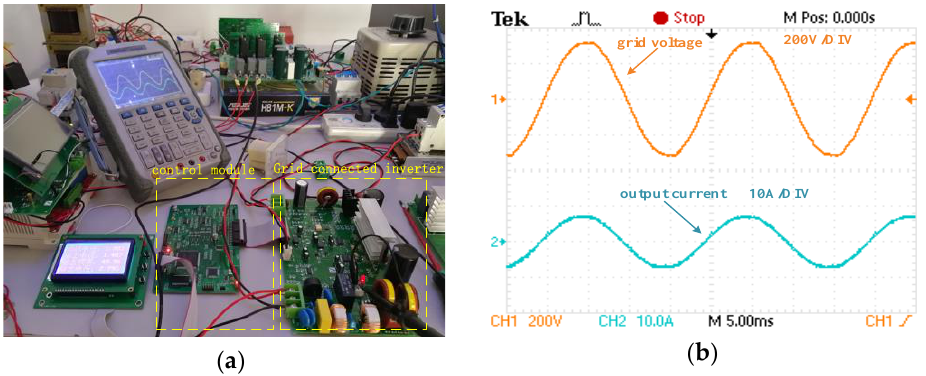
Figure 11. Selection of control parameter. ( a ) The optimal parameter is selected through the bifurcation diagram and the total harmonic distortion; ( b ) The time-domain waveform of the output current corresponding to the selected control parameters.